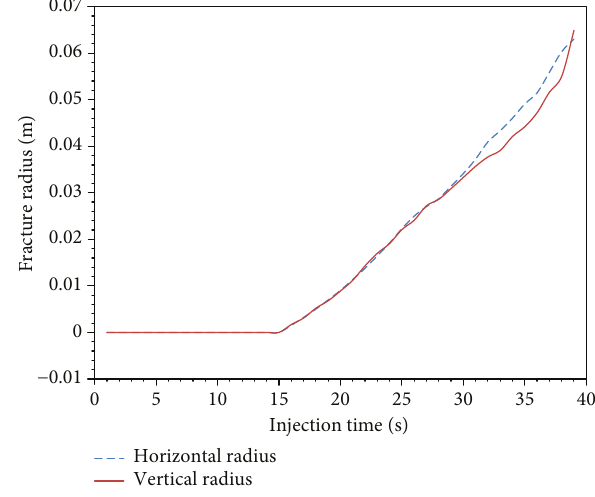
Figure 6: Development of the seepage area versus injection time in the intact sample.